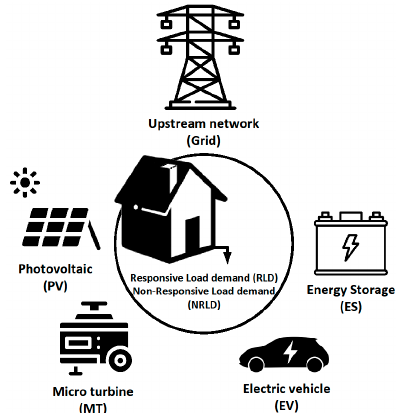
Figure 1. The proposal schematic diagram.